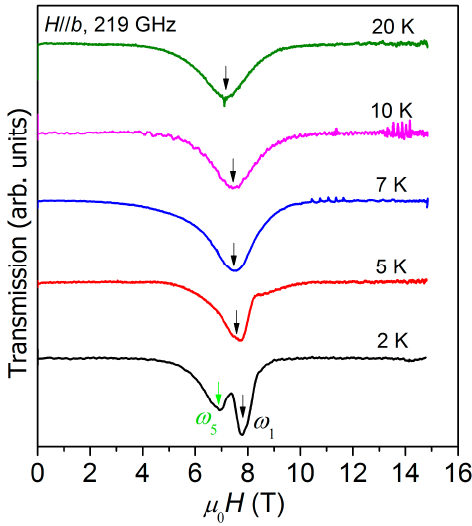
Figure 4. Temperature-dependent ESR spectra measured at 170 GHz along the easy b axis.